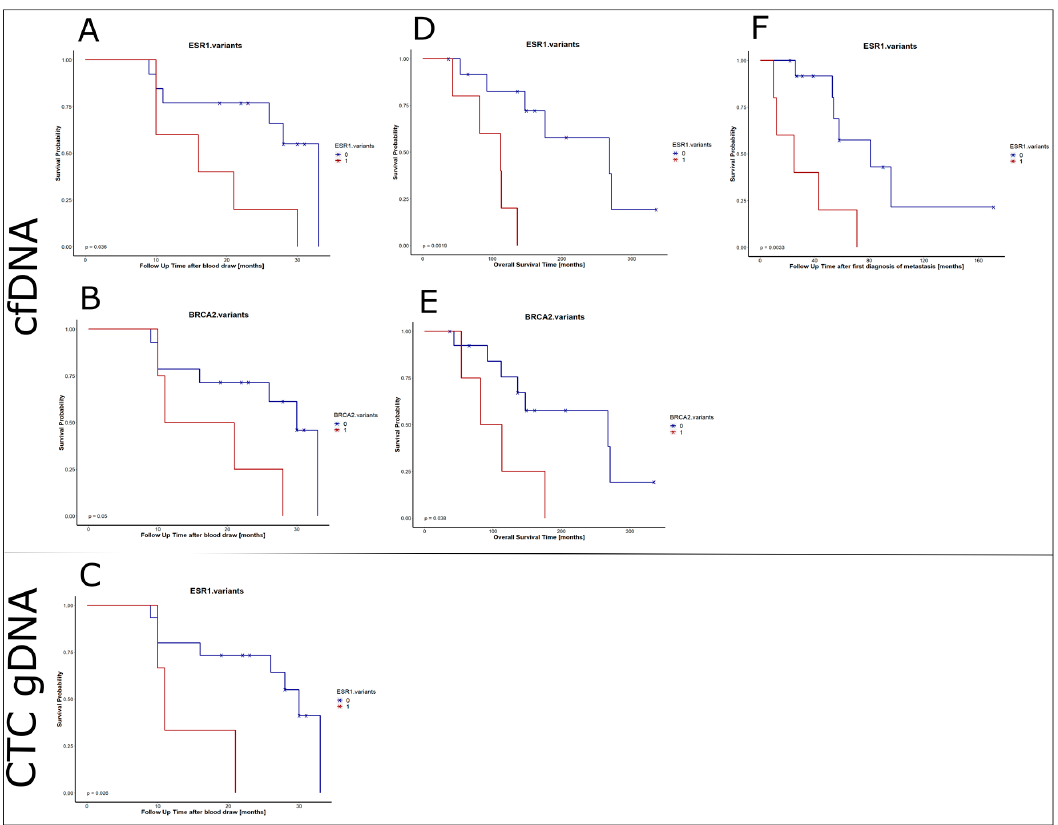
Figure 4. Kaplan Meier curves illustrating the prognostic value of ESR1 variants and BRCA2 variants. Data of patients with at least one variant located in the ESR1 ( A , C , D , F ) or BRCA2 ( B , E ) gene is depicted in red. Correlations were calculated to survival time after the blood was drawn ( A – C ), survival time after first diagnosis ( D , E ) and survival time after first diagnosis of metastasis ( F ). Only significant correlations (calculated by Log Rank (Mantel–Cox) test ( p -value < 0.05)) are shown for cfDNA variants ( A , B , D – F ) and CTC gDNA ( C